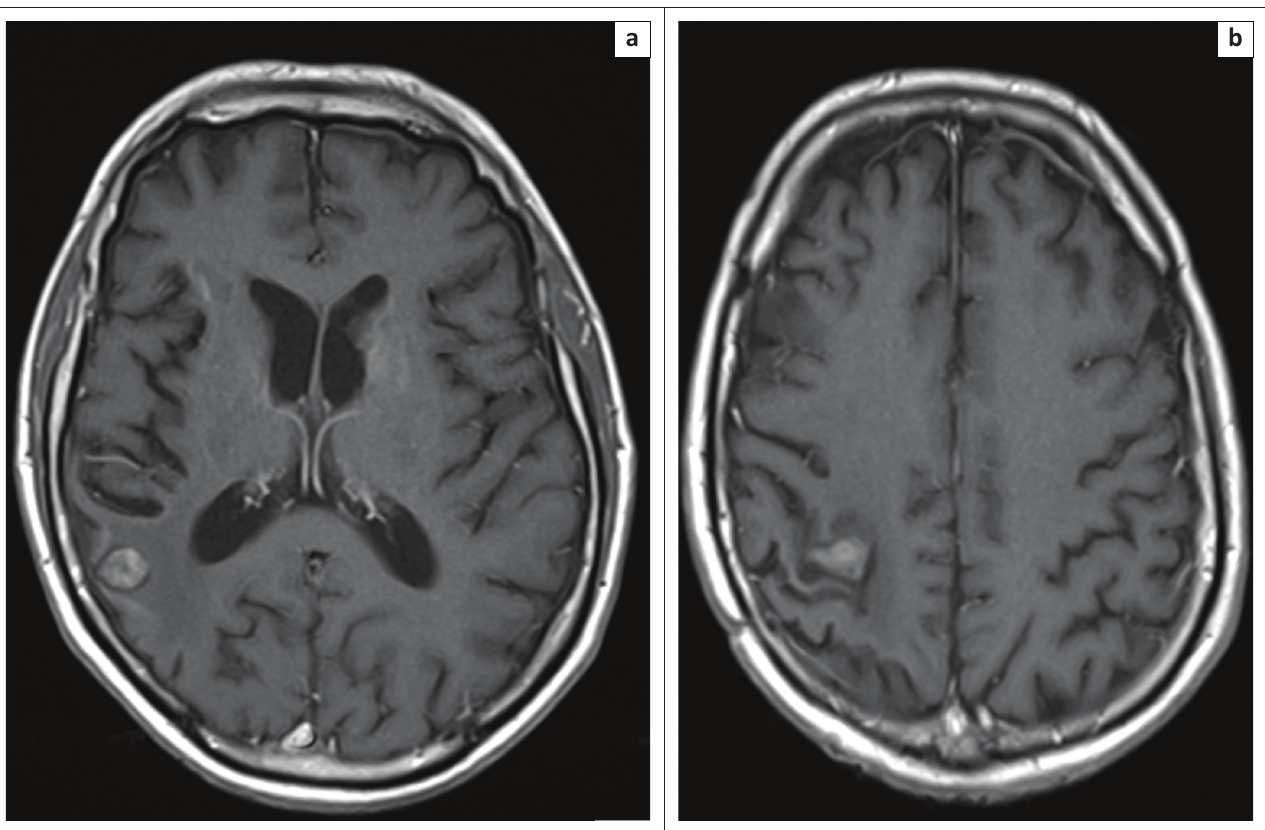
FIGURE 5: Post-gadolinium contrast enhanced T1 axial slices from MR brain following four cycles of MATRix chemotherapy, which shows marked interval improvement in both the size of the ring-enhancing lesions (a) and the degree of peri-lesional oedema (b), in keeping with positive disease